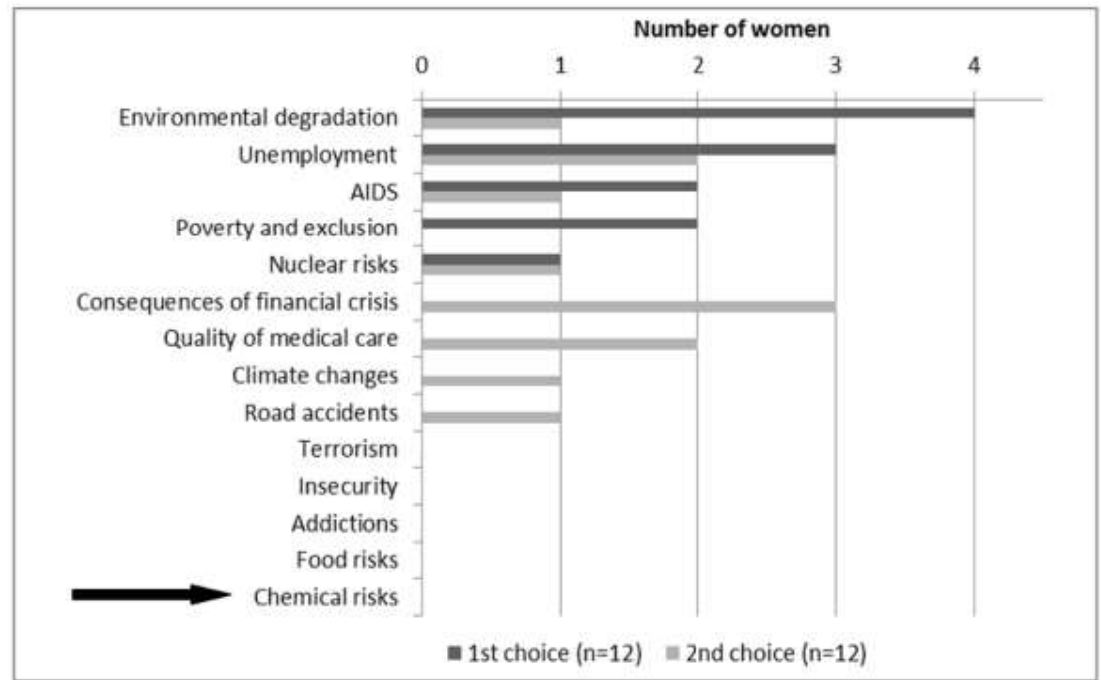
Figure 3. Distribution of pregnant women’s choices for the two most serious current problems. From the data collected from the quantitative study, a first bivariate analysis of each determinant was conducted in order to keep only the statistically significant ones. Means for our EDC risk perception score according to identified determinants; data in bivariate analysis and model analysis are presented in Table 4. The variables “strong maternal figure”, “locus of control (chance)”, “locus of control (other powerful persons)”, “self-esteem score”, “perceived health” and “perceived anxiety trait” were not significant in bivariate analysis. R 2 was 21% for the chosen model. Finally, in this model, age and knowledge significantly increased EDC risk perception.